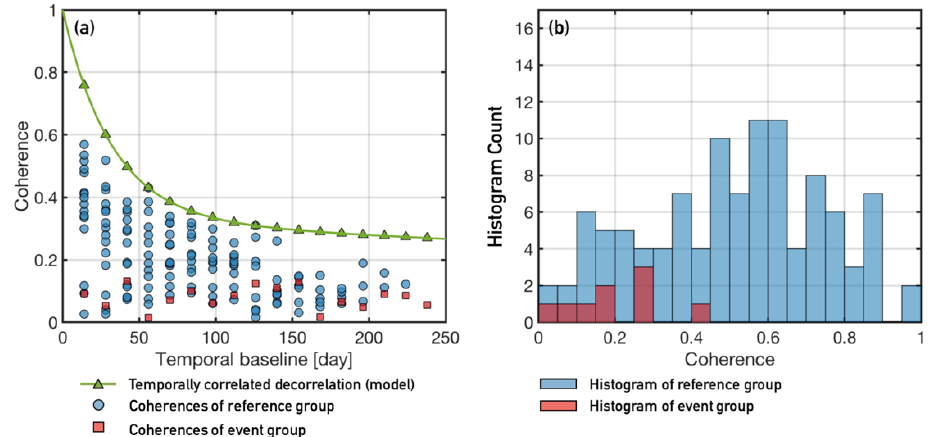
Figure 3. ( a ) Coherence interpretation using the temporal decorrelation model. The exponential curve (green line) describes temporal behaviors in terms of long-term coherence. Blue circles represent the coherences before the event. Red squares are the coherence of co-event pairs. ( b ) Histograms of the reference group and event group.